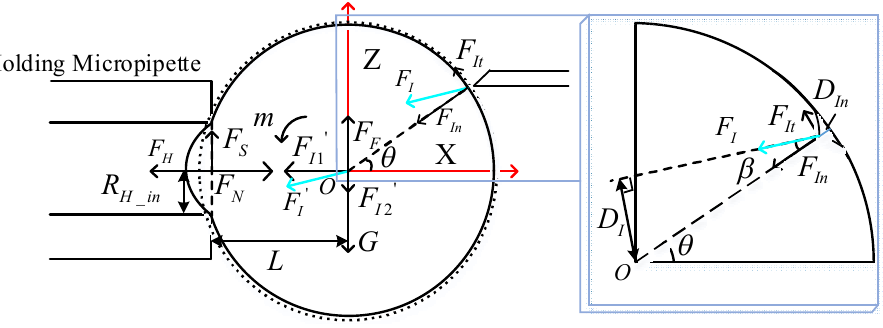
Figure 4. Force analysis of oocyte in the X-Z plane.